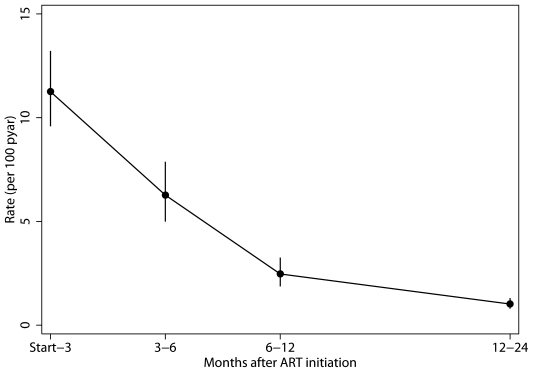
Tuberculosis incidence rates after ART initiation.TB incidence rates according to time of TB occurrence post-ART. Point estimates of incidence rates (cases/100pyar, [95% CI]): 0–3 months: 11.25 (9.58–13.21), 3–6 months: 6.27 (4.99–7.87), 6–12 months: 2.47 (1.87–3.36) and 12–24 months: 1.02 (0.80–1.31). (ART, antiretroviral therapy; TB, tuberculosis; CI, 95% confidence interval; pyar, person years at risk.)